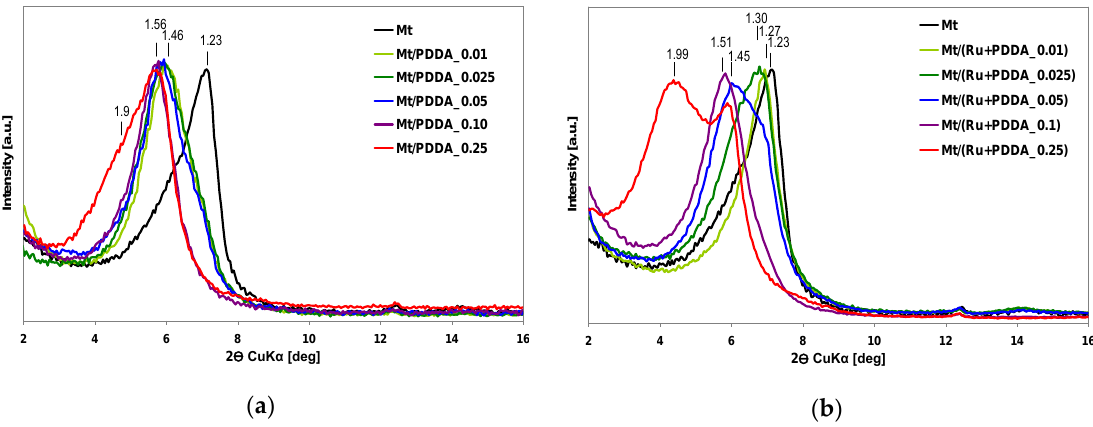
Figure 2. ( a ) Effect of polydiallyldimethylammonium (PDDA) loading on the XRD pattern of parent montmorillonite; ( b ) Effect of Ru insertion by method I on XRD pattern of montmorillonite (Mt) intercalated with PDDA cations (PDDA loadings as in Figure 2a).